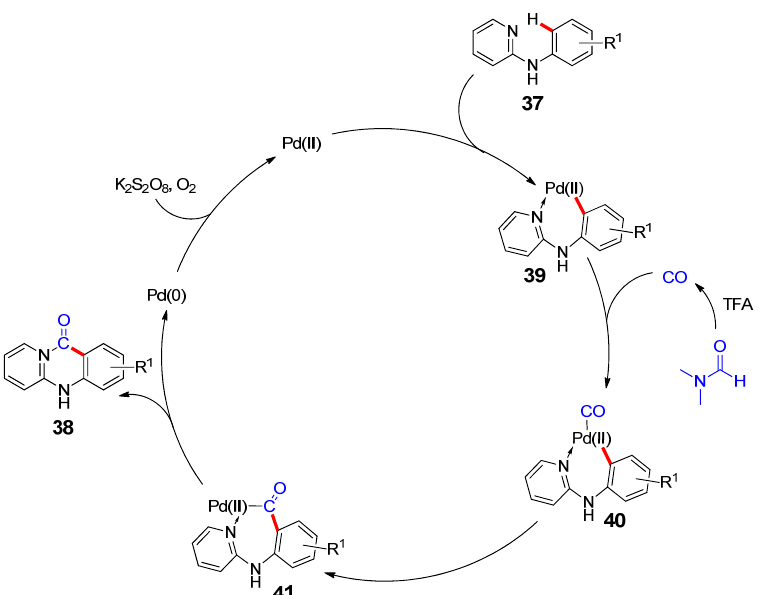
Scheme 15. Proposed reaction mechanism for the synthesis of quinazolinones 38 by Pd-catalyzed carbonylative cyclization of N -arylpyridin-2-amines 37 using DMF as a CO surrogate, reported in 2015 by Wu and co-workers [41].